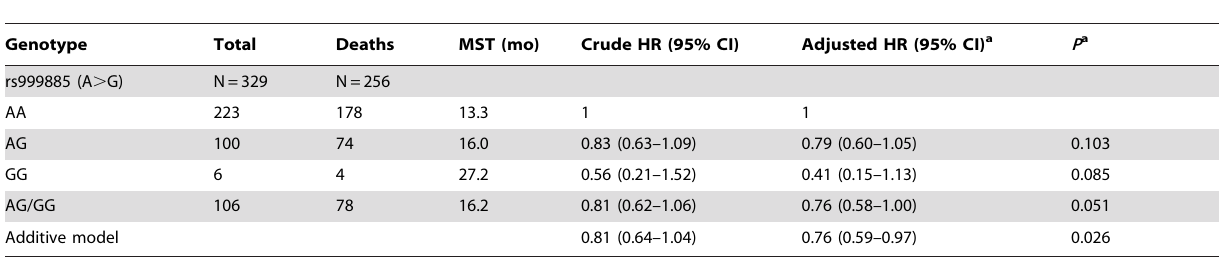
Table 1. Genotypes of miR-106b-25 rs999885 and HCC patients’ survival.